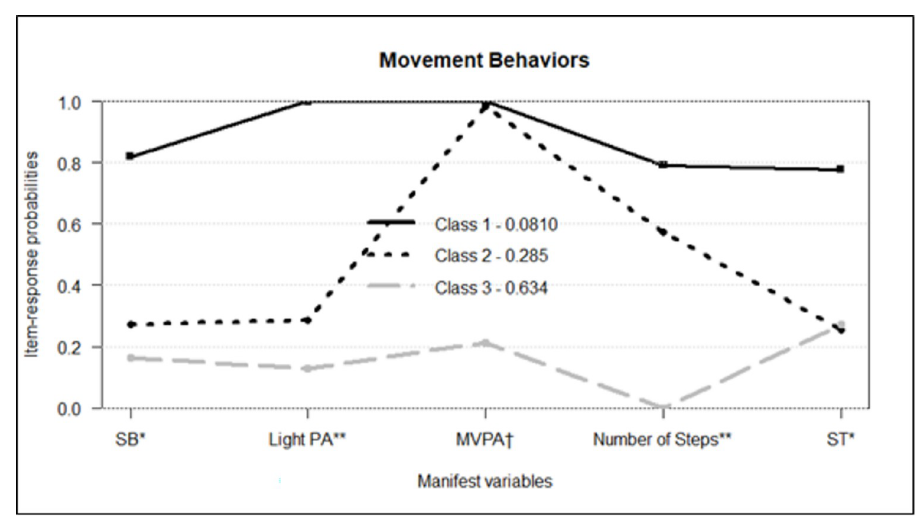
Fig 1. Adolescents’ LCA model of movement behaviors. Class 1: Active and Non-sedentary ( γ : 8.10%); Class 2: Active and Sedentary ( γ : 28.50%); Class 3: Inactive and Sedentary ( γ : 63.40%). SB, sedentary time; PA, physical activity; MVPA, moderate to vigorous physical activity; ST, screen time. � Categorized by the 25 th P percentile. �� Categorized by the 75t th P percentile. †60-minute cut-off point.